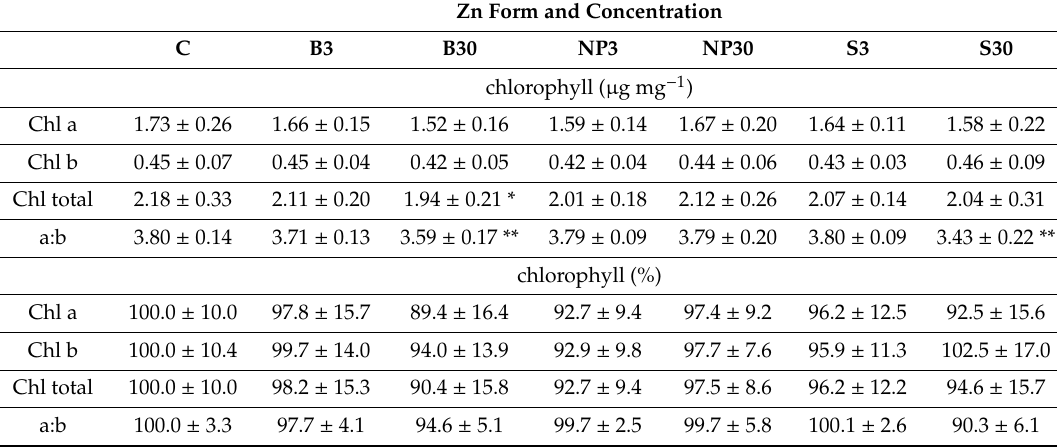
Table 2. Chlorophyll a and b, total chlorophyll, and chlorophyll a / b ratio. Measurement were performed with 1 inch length specimens cut out of the top of the first and second leaves of seven barley shoots sampled for each treatment group after 10-day